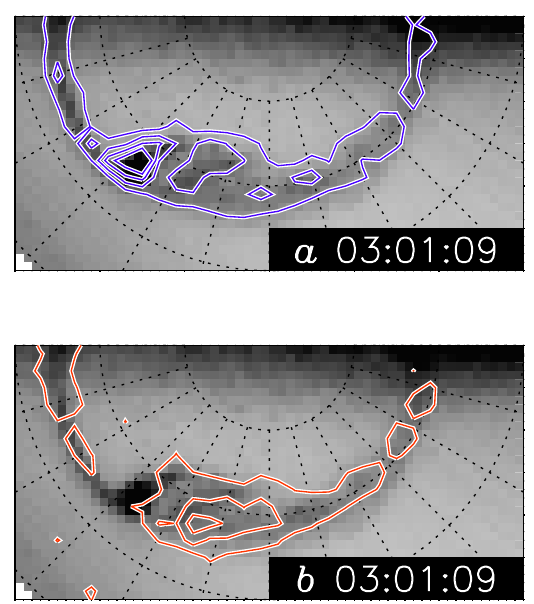
Fig. 7. An FUC/WIC auroral snapshot from 03:01 UT (Fig. 6g), superimposed on which are contours of auroral brightness observed by the (a) SI13 and (b) SI12 channels of FUV, sensitive to electrons and protons,